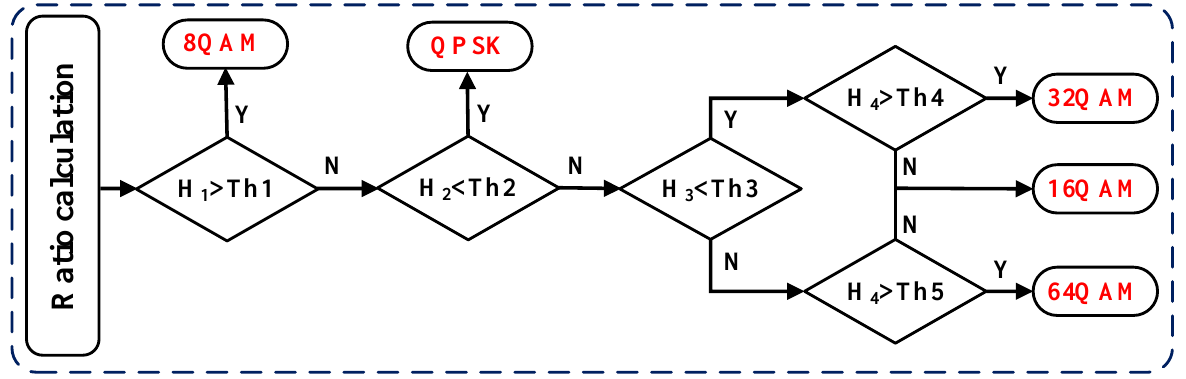
Figure 7. Flow chart of the proposed MFI scheme.